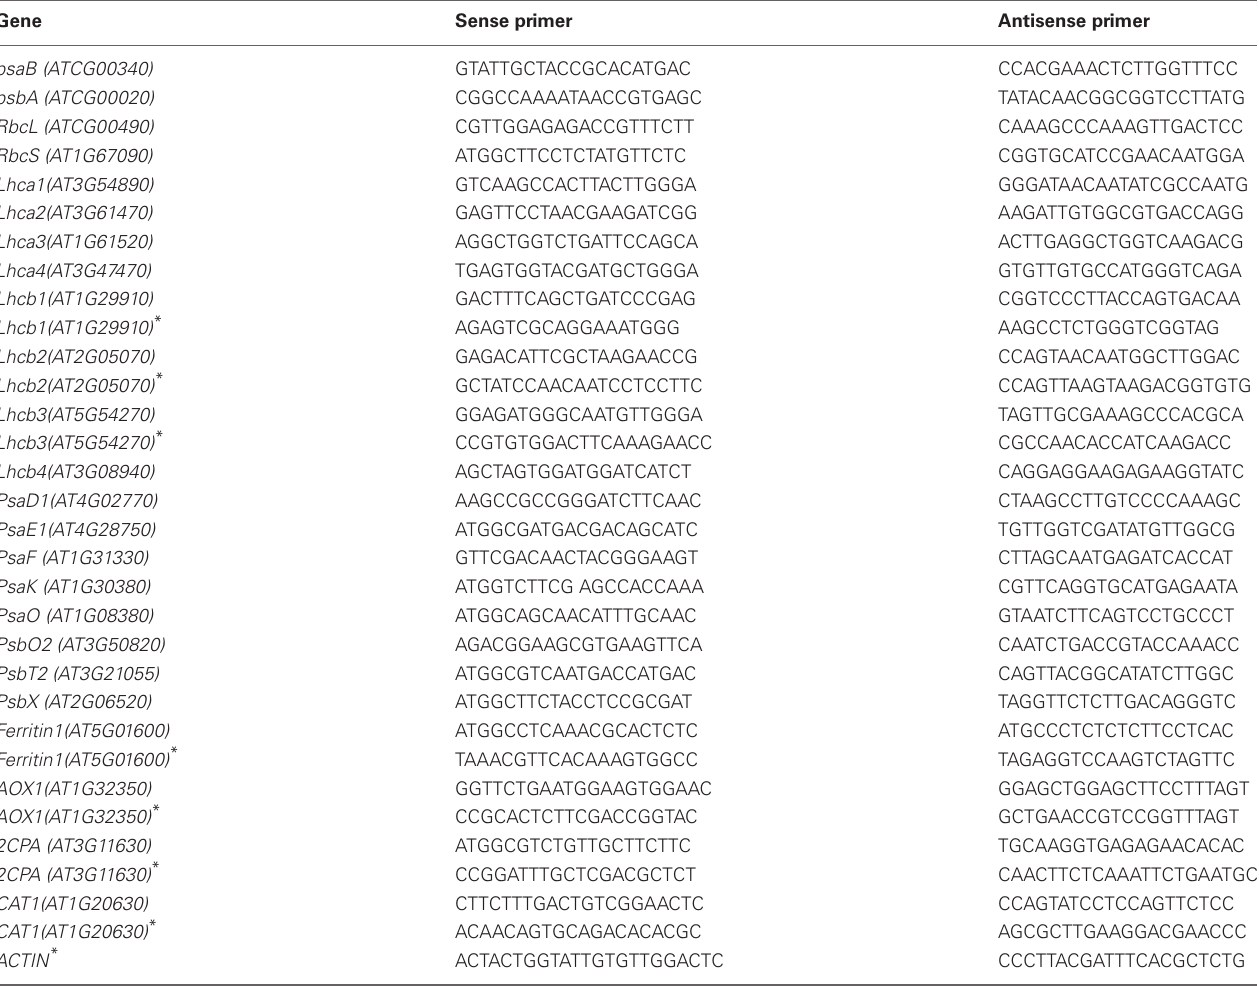
Table 1 | Oligonucleotide sequences employed for gene expression analysis. Gene Sense